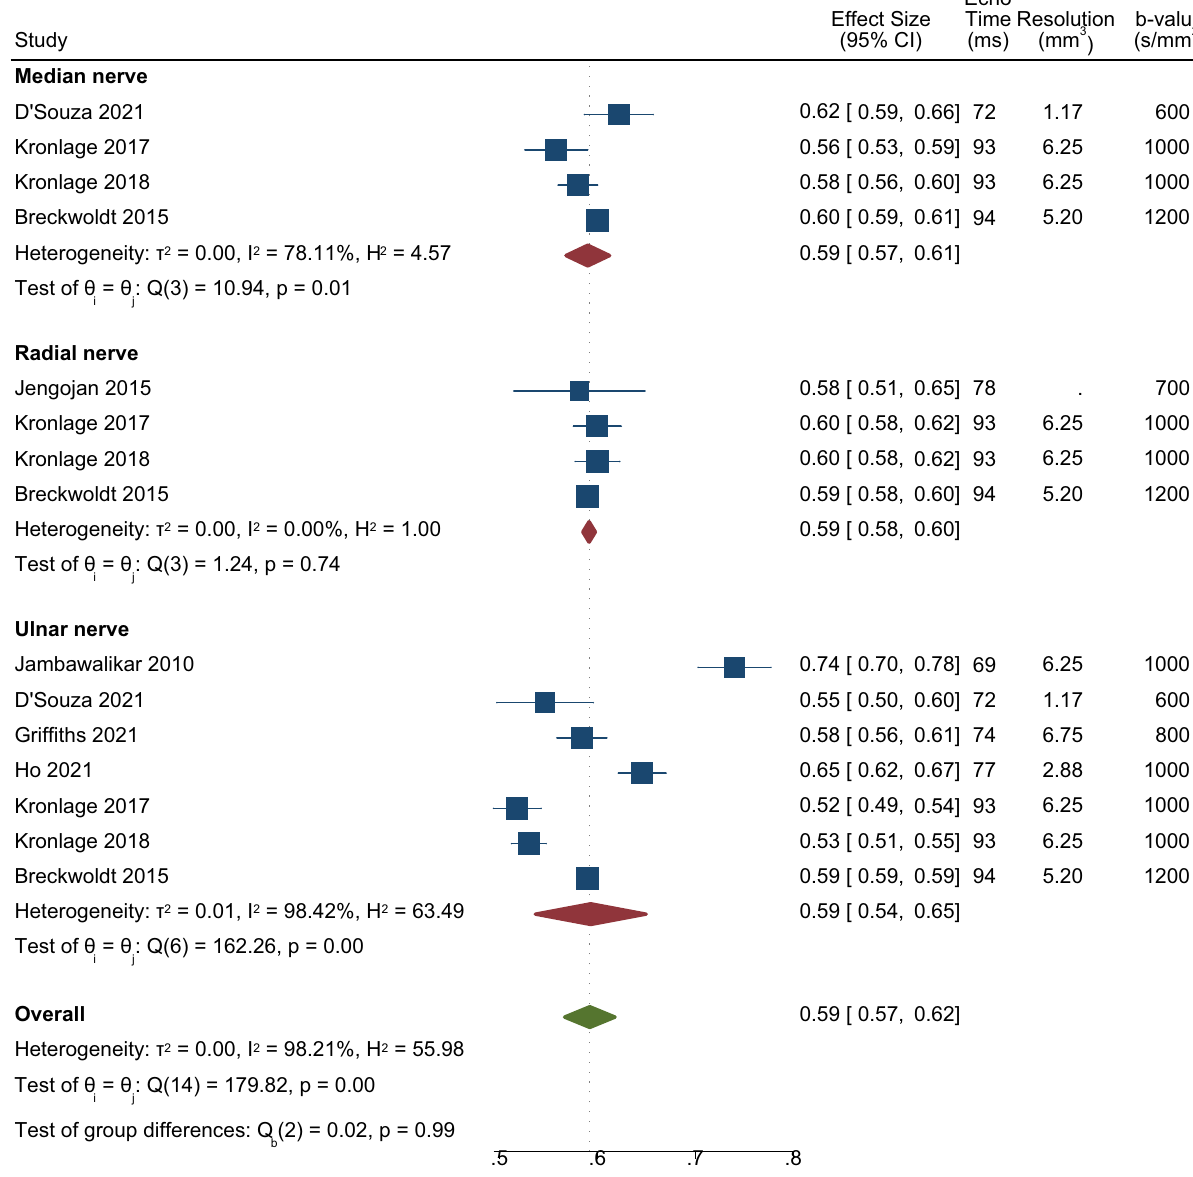
Figure 1. Forest plot of the normal FA of the median, ulnar and radial nerves in the arm, sorted by the echo time and eFig. S16) with no significant difference between the nerves (p = 0.752, I 2 98%). The normal AD of the median, radial and ulnar nerves in the forearm was 1.91 × 10 –3 mm 2 /s (CI 1.77, 2.04; eFig. S17) with no significant dif- ference between the nerves (p = 0.562, I 2 95%). Leave-one-out meta-analysis did not detect any outlier studies. Meta‑regression. Multivariable meta regression showed that the TE, TR, b-value, spatial resolution, ana- tomical location and age of the subject moderated DTI metrics within peripheral nerves (Table 1 and Fig. 4). Both anisotropy and diffusivity were dependent on age whereby each decade of life reduced the FA by 0.05 (CI 0.007, 0.02) and increased MD by 7.8 × 10 –5 mm 2 /s (CI 3.3 × 10 –5 , 1.2 × 10 –4 ). Increments in the b-value of 100 s/mm 2 reduced the observed MD by approximately 0.038 mm 2 /s (CI 0.064–0.012) without affecting the FA. increments of 10 ms in the TE reduced the FA within peripheral nerves by approximately 0.056 (CI 0.079, 0.033) without affecting the MD. Increasing the spatial resolution by 1mm 3 downwardly biased the FA by 2% (CI 3–4) and upwardly biased the MD by 0.02 (CI 9.1 × 10 –4 , 0.04). The nerves within the forearm had a 6% higher FA than nerves within the arm. FA and MD appeared to be robust to N D .